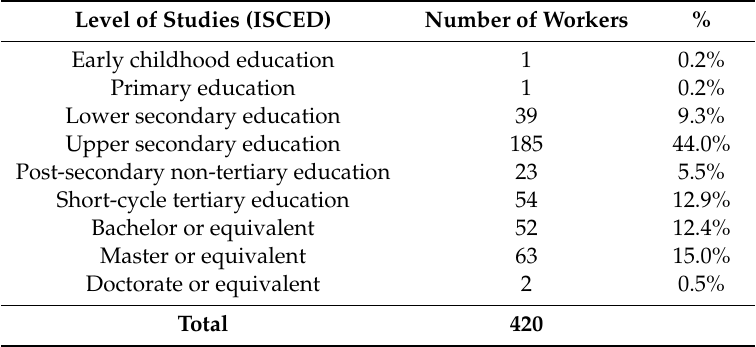
Table 3. Distribution of the sample of workers according to their household’s total monthly income. Is Your Household Able to Make Ends Meet? Number of Workers % Very easily